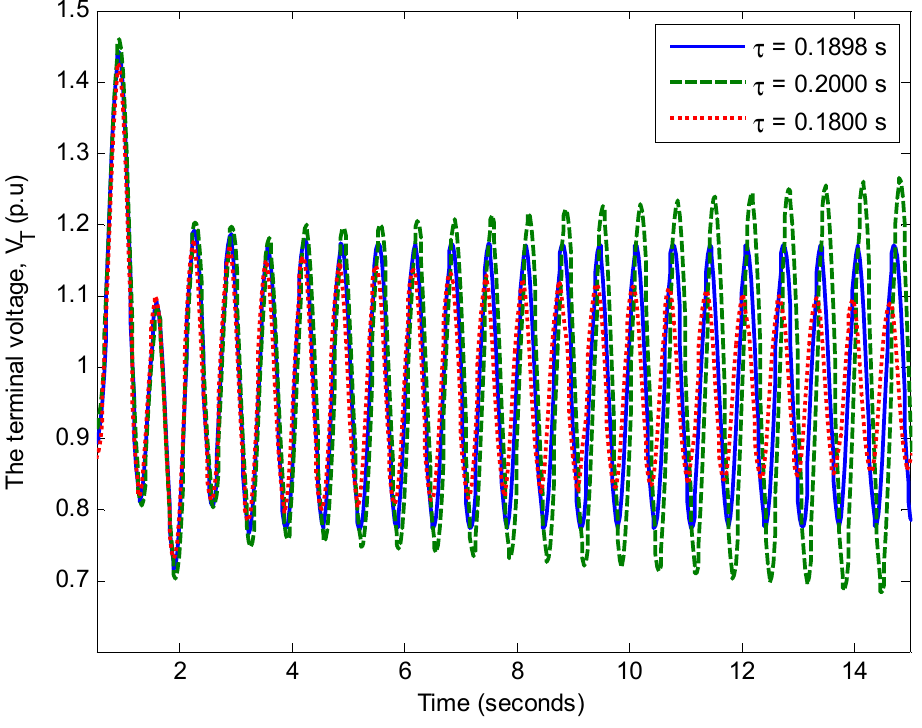
Figure 8. The terminal voltage with different time delays.